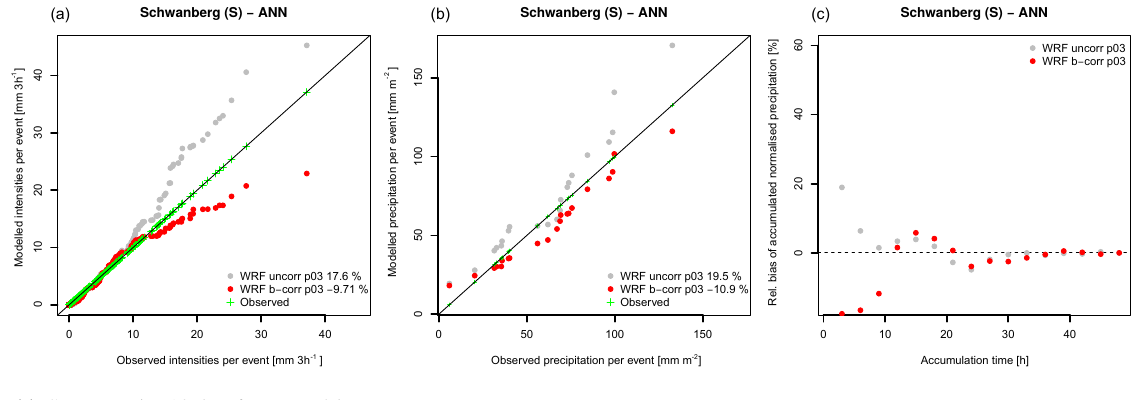
Figure 11. Same as Fig. 10, but for WRF 3km.